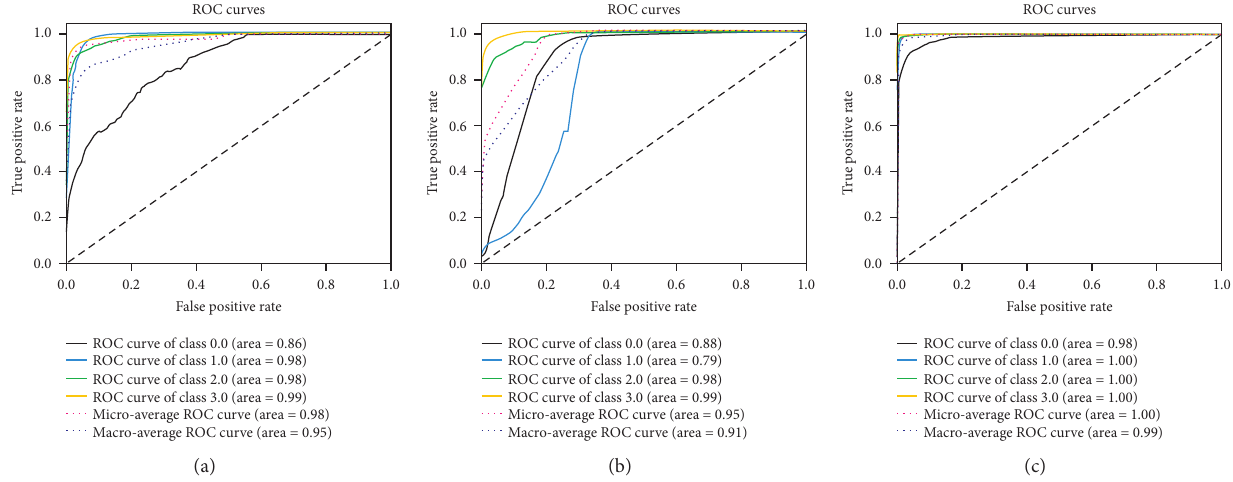
Figure 13: ROC curve performance in three models: Bagging (a), AdaBoosting (b), and GFM-Net (c) The treadmill speed is set to 1.0m/s.